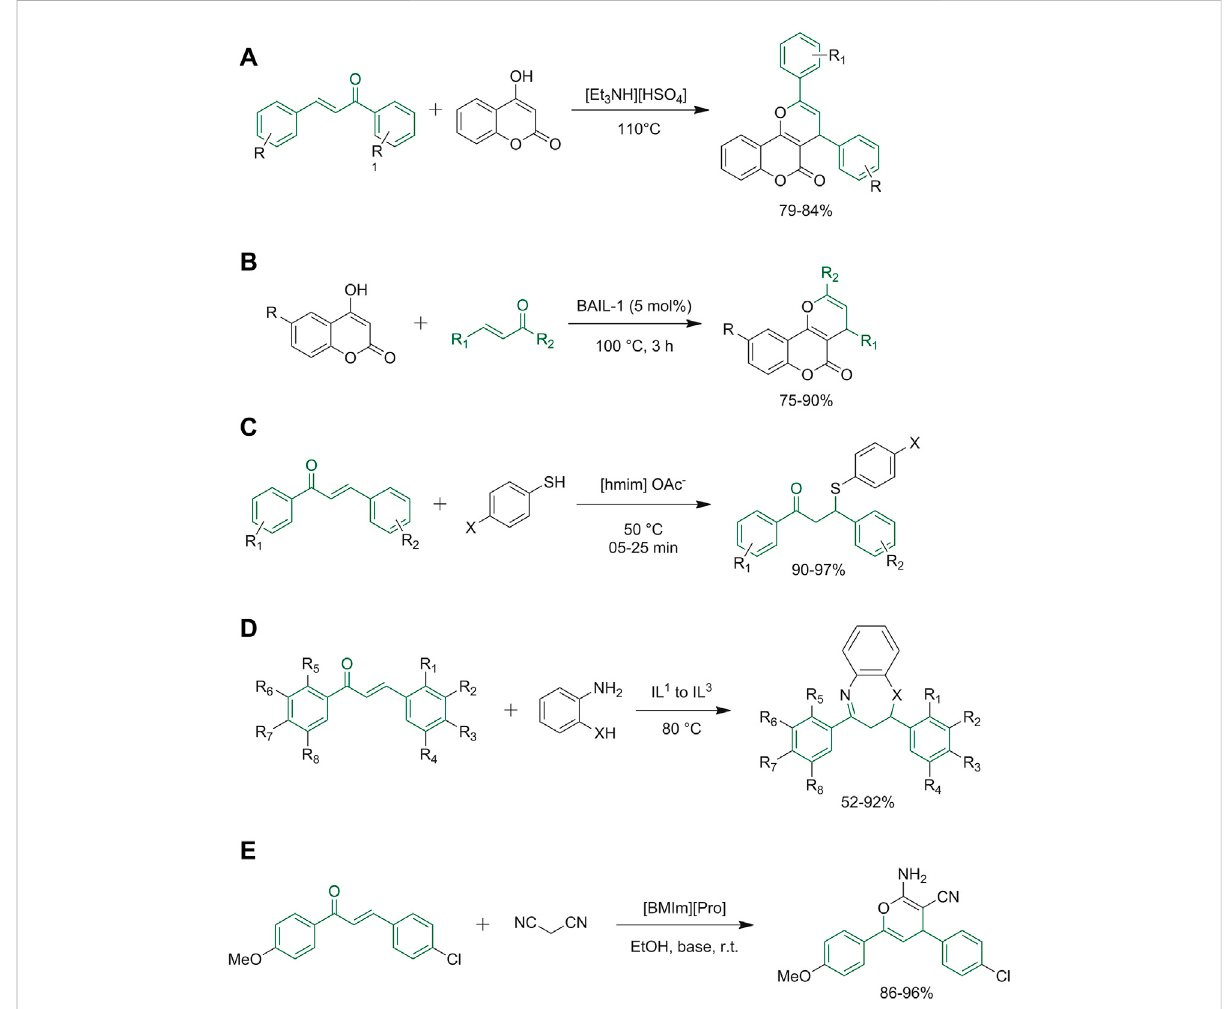
FIGURE 4 (A) Synthesis of pyrano [3,2- c ]coumarins; (B) synthesis of pyrano [3,2- c ]coumarin using BAIL-1 as liquid ionic; (C) synthetic route for 1,3- diphenyl-3-(phenyl thio) propan-1-one derivatives; (D) Michael addition followed by cyclo-condensation to give 1,5-benzodiazepines and 1,5- benzothiazepines; (E) formation of the 2-amino-3-cyano-4 H-